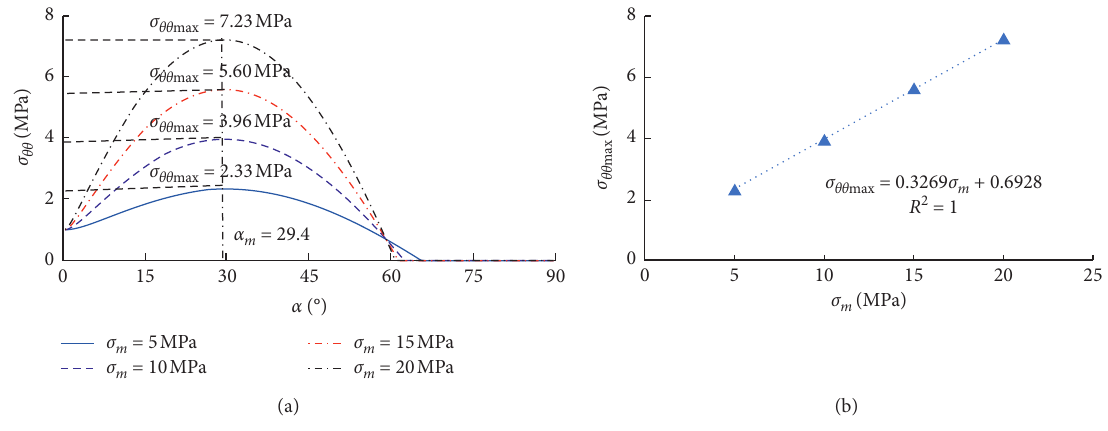
Figure 5: Effect of ground stress on maximum circular stress.